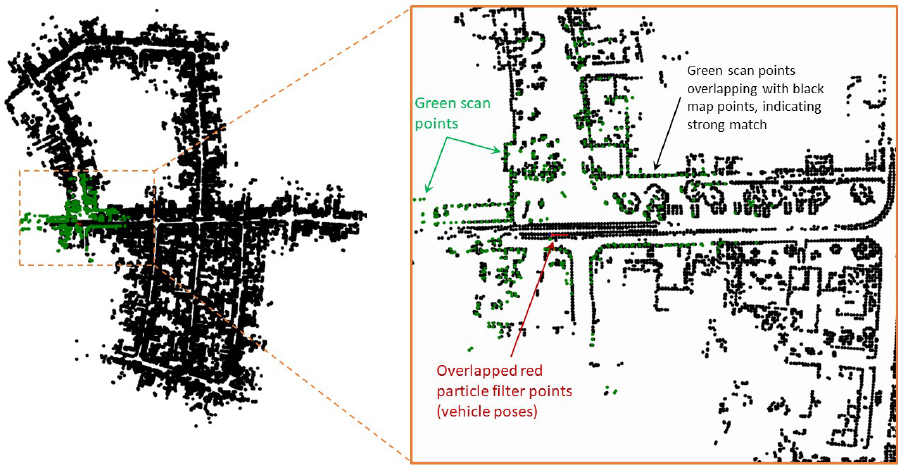
Figure 8. Snapshots of a simulation at k =